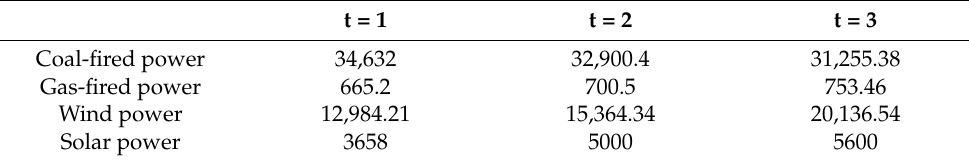
Table 3. The pre-regulated installation capacity in Inner Mongolia (MW) [32].